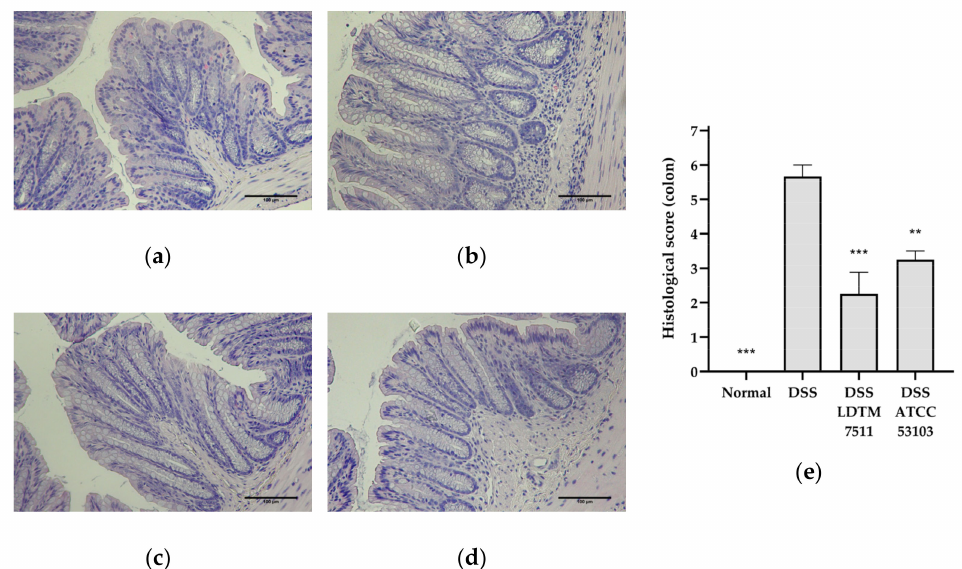
Figure 3. Representative colonic architecture and histological score in hematoxylin and eosin (H&E) staining. ( a ) Normal group; ( b ) DSS group; ( c ) DSS LDTM 7511 group; ( d ) DSS ATCC 53103 group; ( e ) Histological score (mean ± SEM, n = 4 in each group). Original magnification, 20 × . Scale bars, 100 µ m. In ( e ), significance is indicated as follows: ** p < 0.01 and *** p < 0.001, compared to the DSS group.